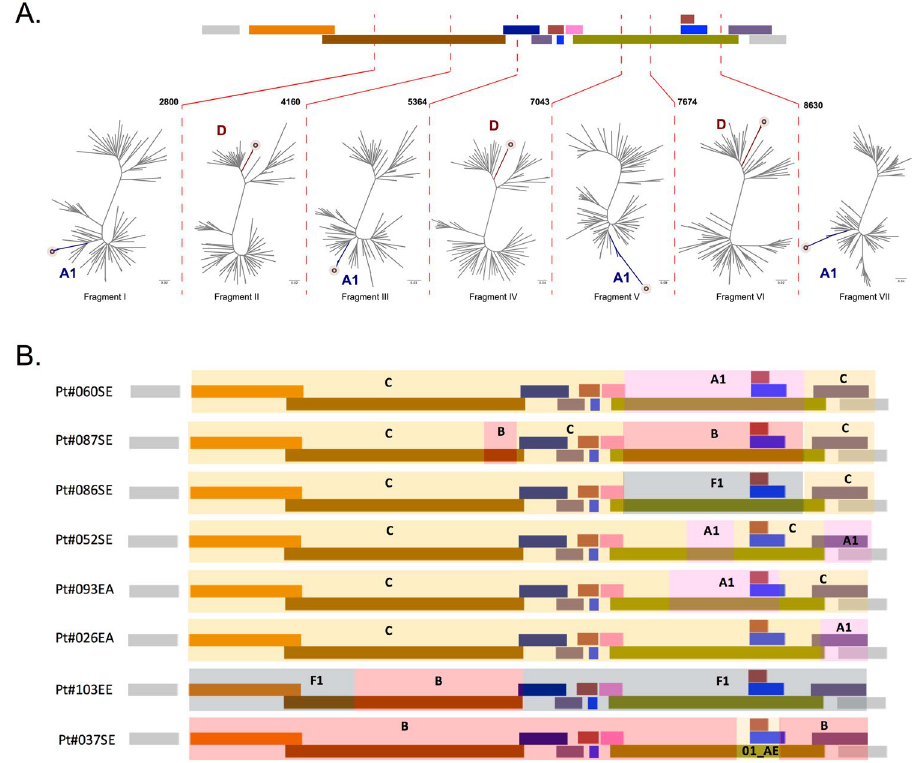
Figure 2. ( A ) Mosaic pattern of three HIV-1 A1D recombinants. Precise inter-subtype recombination analysis was performed using bootscanning analysis and similarity plot analysis implemented in SimPlot ver. 3.5.1 with 500 bp window size and 20 bp step size 36 , Recombination Detection Program (RDP) ver.4 37 and jumping profile Hidden Markov Model (jpHMM) 38 . The recombination breakpoints are indicated as an HXB2 position. ML-phylogenetic analysis was used to confirm the recombination events. Patients were self-reported to be men who have sex with men and infected in Sweden. ( B ) Mosaic pattern of eight other HIV-1 URFs. These URFs did not belong to any identified transmission cluster. SE: patient infected in Sweden; EE: patient infected in East- Europe; EA: patient infected in East